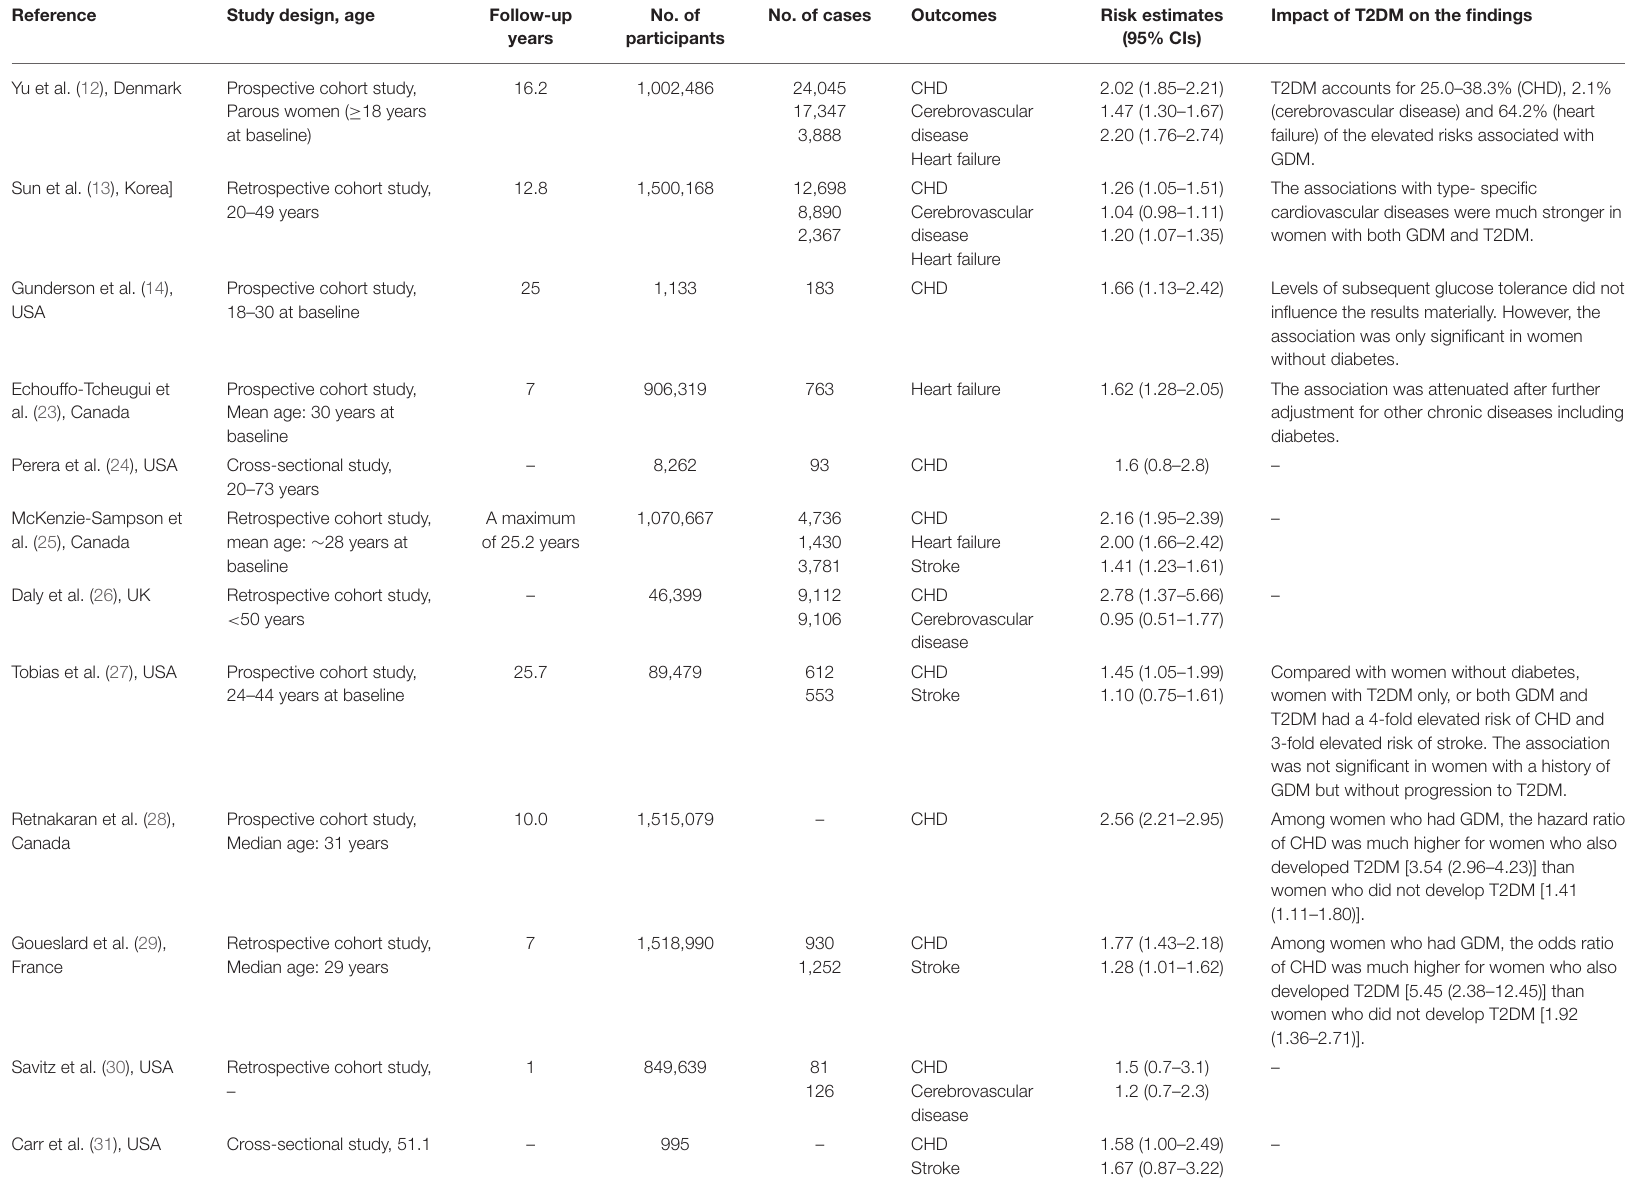
TABLE 2 | Included studies on the associations between gestational diabetes mellitus and type-specific cardiovascular